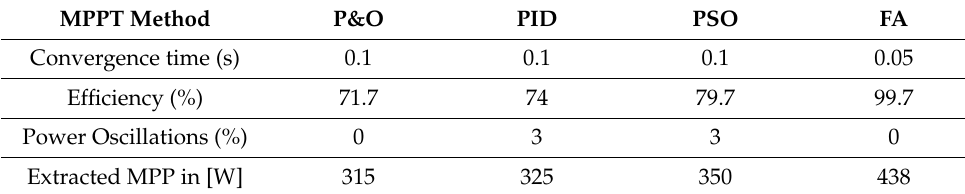
Table 6. Performance comparison of FA, P&O, PID and PSO (Case 2).